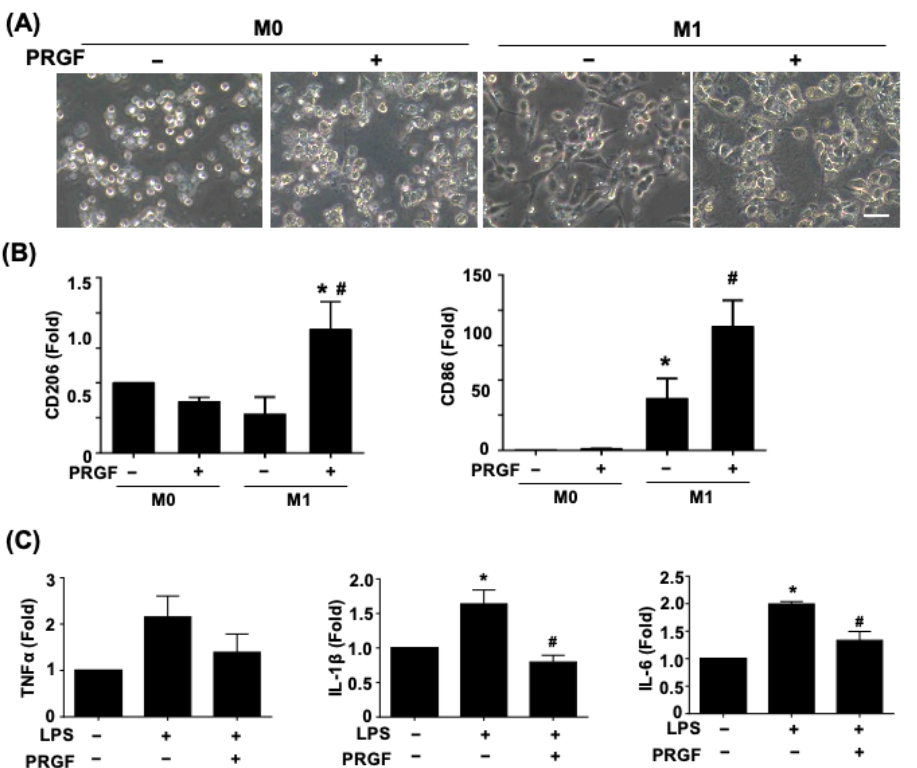
Figure 2. PRGF enhanced M2-macrophage polarization and inhibited the LPS-induced inflammatory SCs. ( A ) Representative phase images revealed a change in cell morphology of PRGF-treated M1 macrophages compared with M1 macrophages. ( B ) The qRT-PCR showed increases in the mRNA expression level for CD206 and CD86 by treating 10% PRGF with the M1-induction media. ( C ) The LPS-induced TNF α , IL-1 β , and IL-6 expressions were inhibited when mixing with 10% PRGF in RT4 SCs. n = 4. Significance was assessed by one-way ANOVA. Data are presented as the mean ± SEM. For panel ( B ) histograms; * p < 0.05 versus M0. # p < 0.05 versus M1. For panel ( C ) histograms; * p < 0.05 versus no LPS and PRGF. # p < 0.05 versus only LPS. Scale bar = 40 µm.